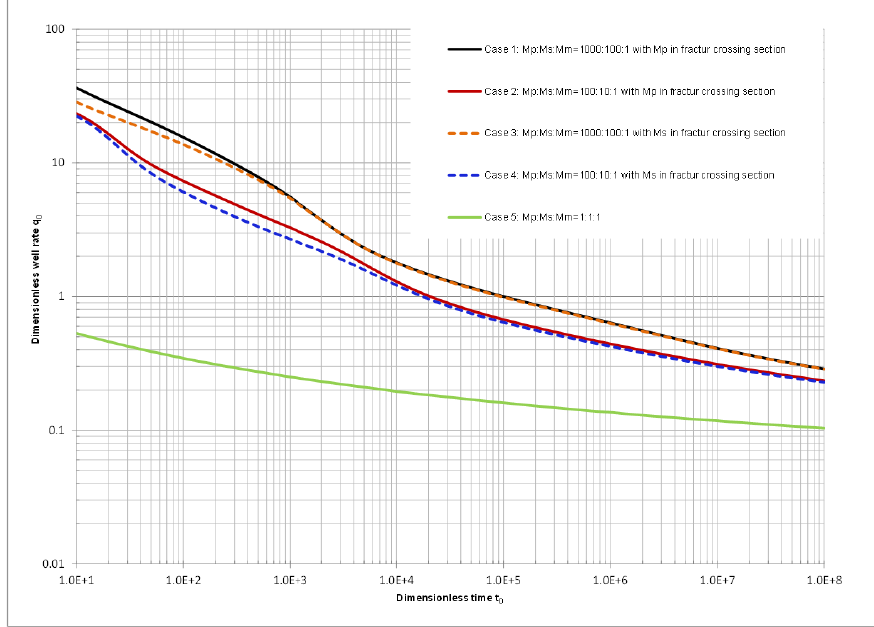
Figure 27. q D responses for the six cases based on the simplified fracture network model.